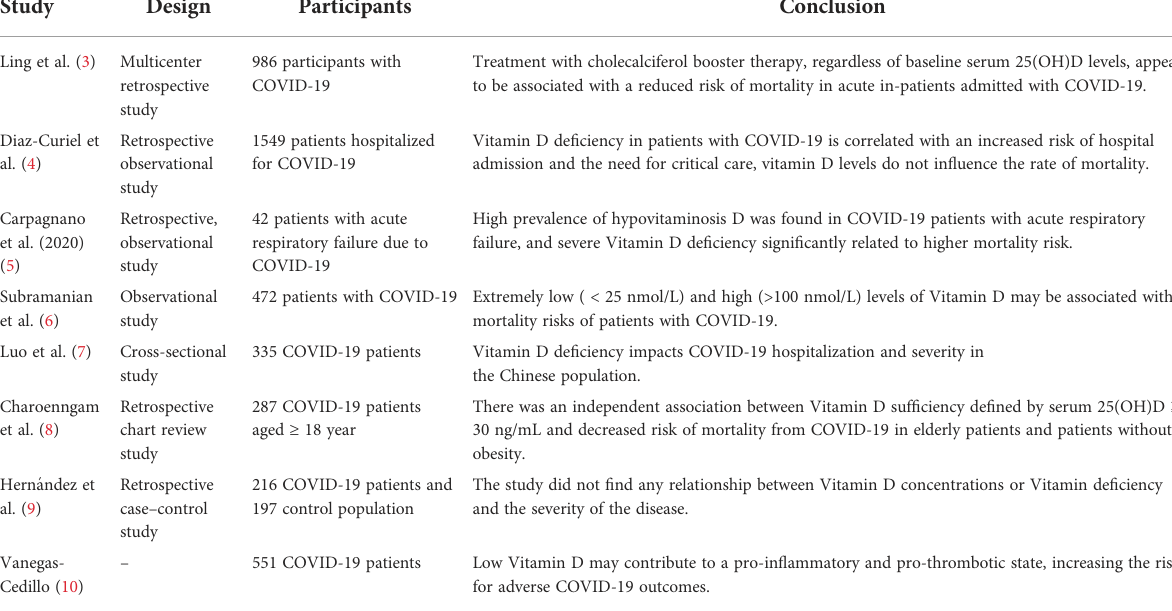
TABLE 1 Summary of observational study